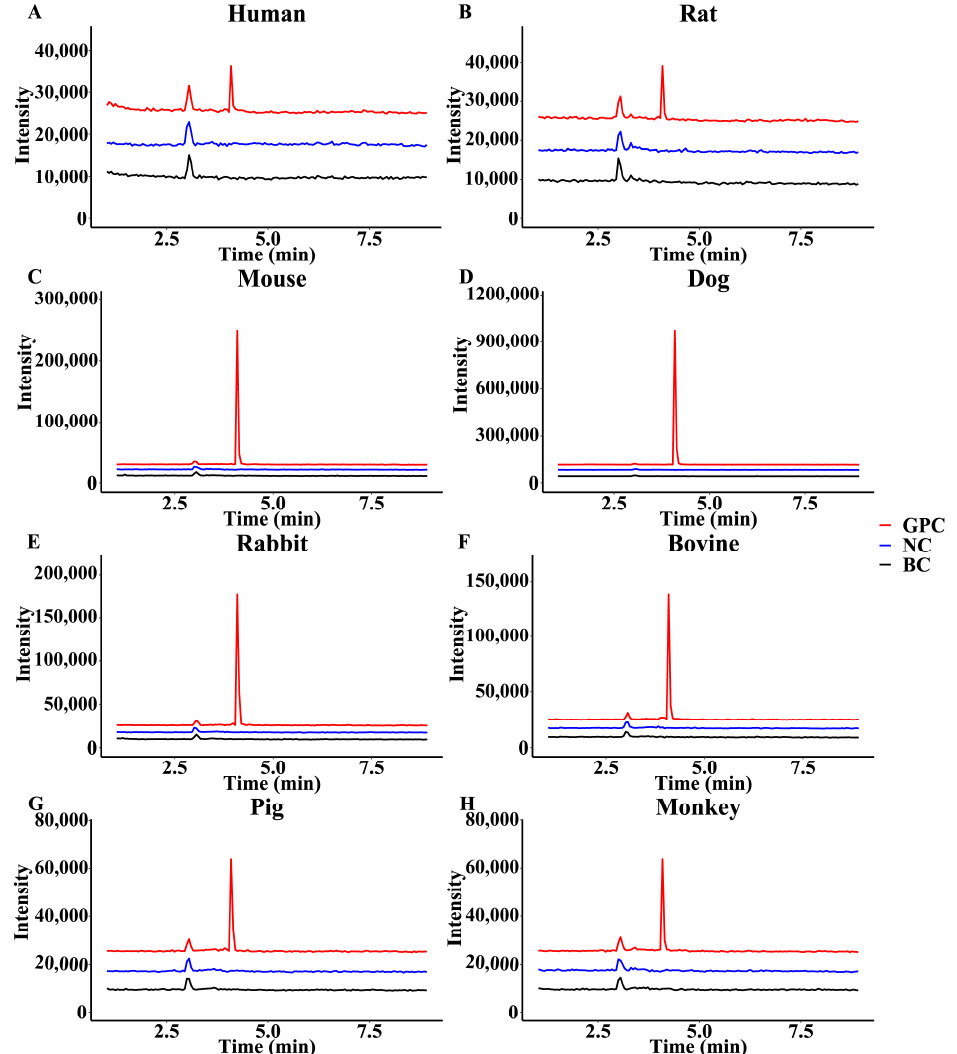
Figure 6. Chromatograms of GPC (10 μ M) glucuronidation metabolites in ( A ) human, ( B ) rat, ( C ) mouse, ( D ) dog, ( E ) rabbit, ( F ) bovine, ( G ) pig, and ( H ) monkey liver microsomes.